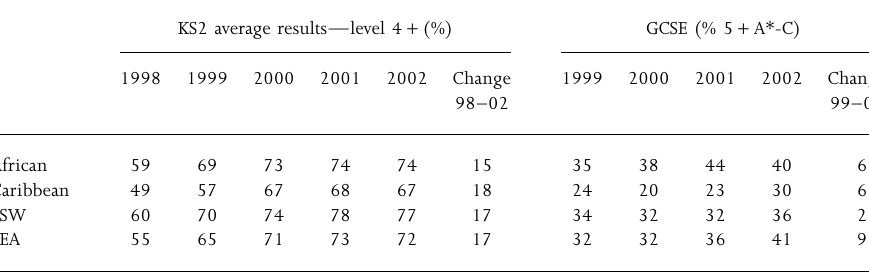
Table 1 Changes in attainment by ethnic origin in LEA